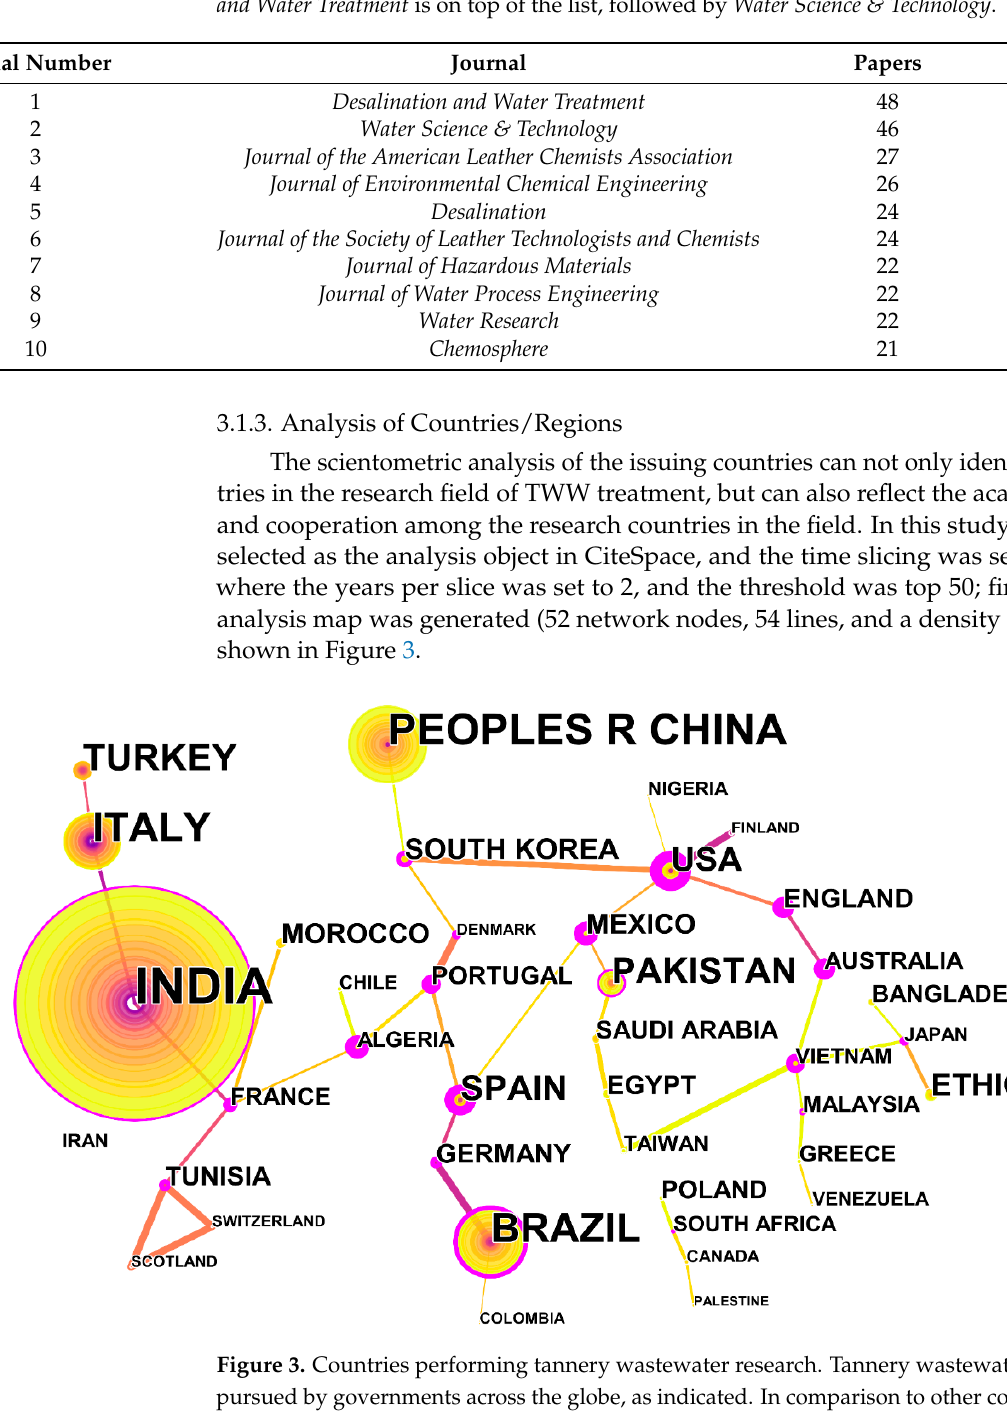
Table 1. Top 10 productive journals in tannery wastewater research. This list summarizes the ten most prolific journals in the field of tannery wastewater research from 1991 to 2022. Desalination and Water Treatment is on top of the list, followed by Water Science & Technology .